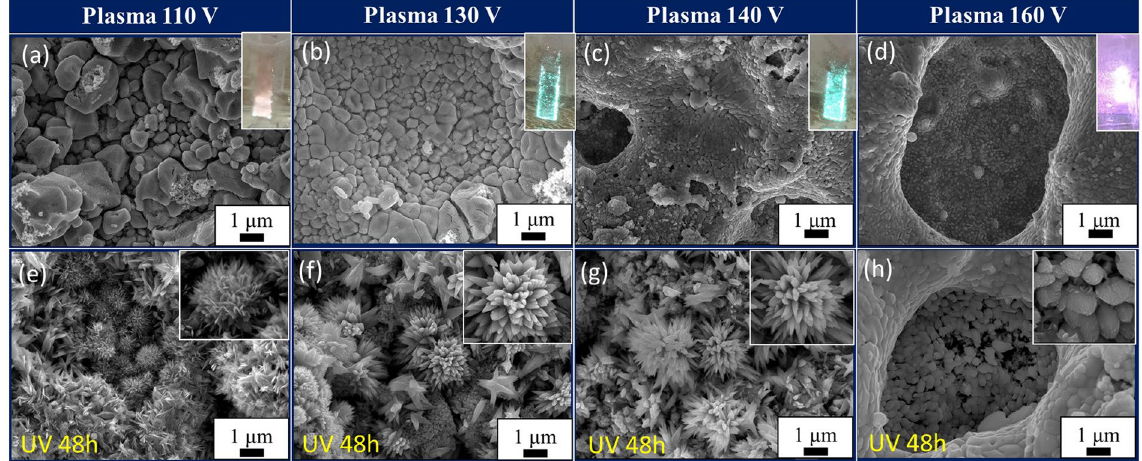
Figure 1. Surface morphology after SPSC of a Cu substrate plate. FE-SEM images of the sample surfaces ( a – d ) after solution plasma treatment at 110–160 V and ( e – h ) samples after 48 hours of UV irradiation followed by the plasma treatments above. Insets of ( a – d ) are photographs of samples during the plasma processing. Insets of ( e – h ) are enlarged views of